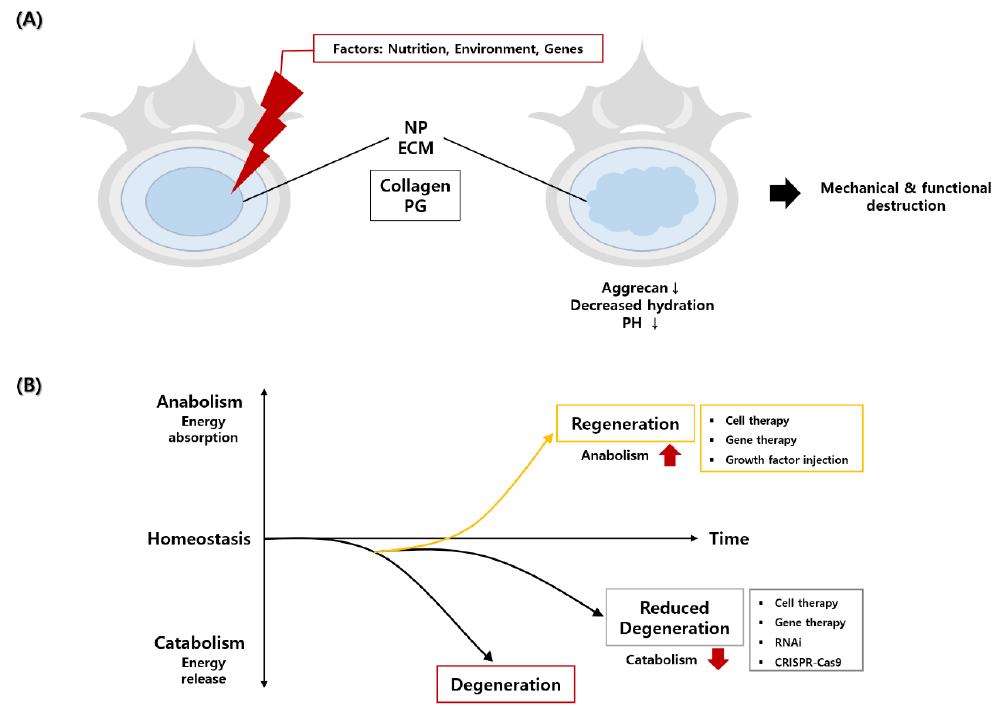
Figure 1. A schematic diagram of the cause of intervertebral disc degeneration and strategies to reduce disc degeneration and promote disc regeneration. ( A ) Nutritional, environmental, and genetic factors have caused changes in collagen and proteoglycan (PG) and the composition of the extracellular matrix (ECM) in nucleus pulposus (NP), resulting in a decrease in aggrecan and pH and loss of hydration, which systematically and functionally destroyed NP. ( B ) Regeneration of degenerated disc could be induced by an increase in anabolism and a decrease in disc degeneration could be induced by a decrease in catabolism.